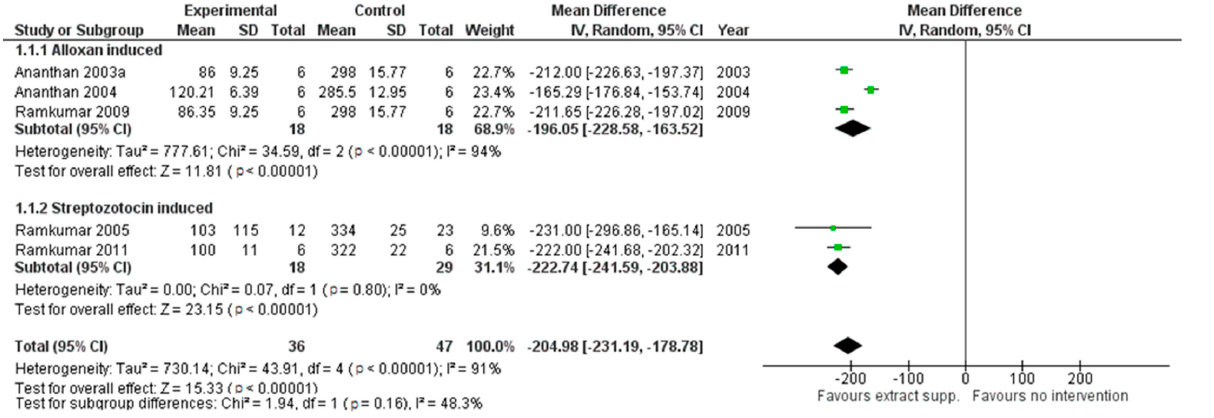
Figure 2. The results of G. montanum supplementation on glycemic levels in serum of induced diabetic rats (Forest plot).